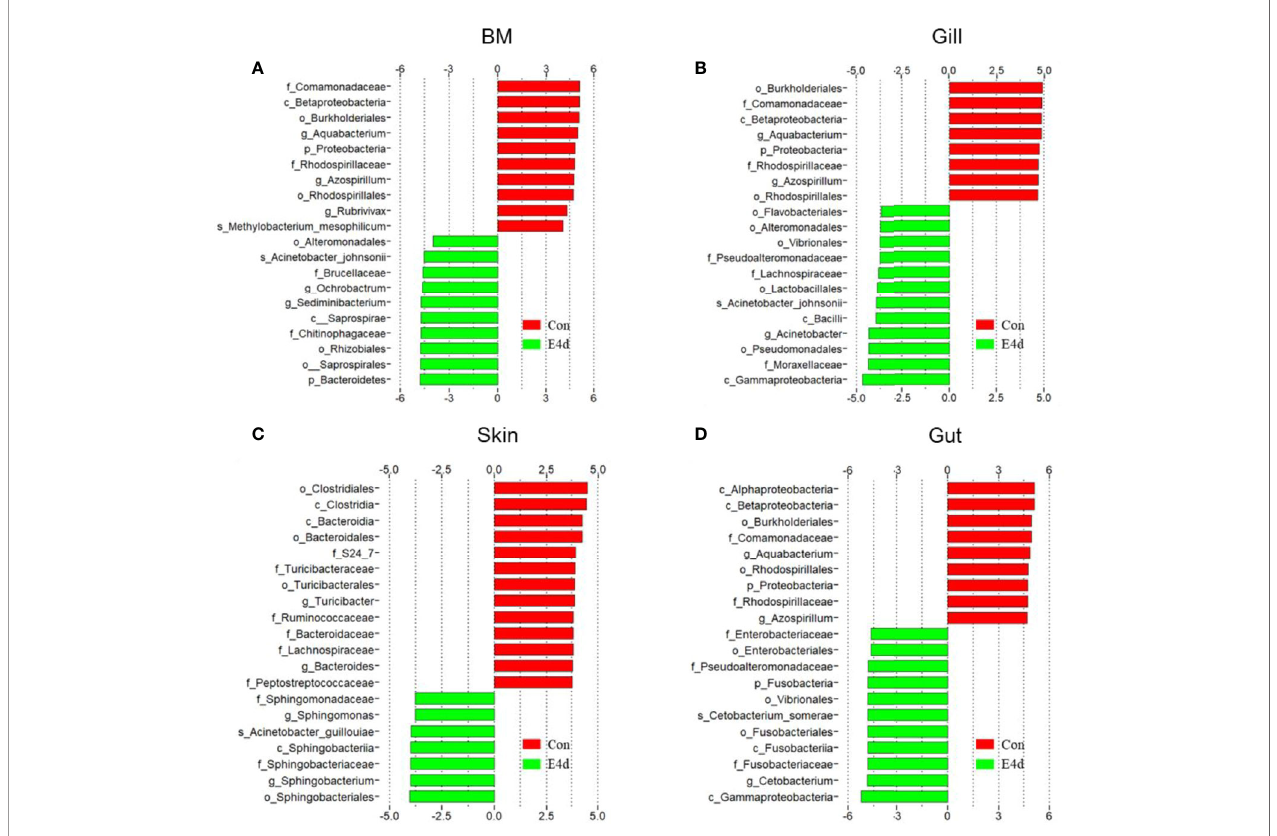
FIGURE 5 | Description of biomarkers that were signi fi cantly different between control and infection groups in common carp BM (A) , gills (B) , skin (C) , and gut (D) . E4d, 4 days after SVCV